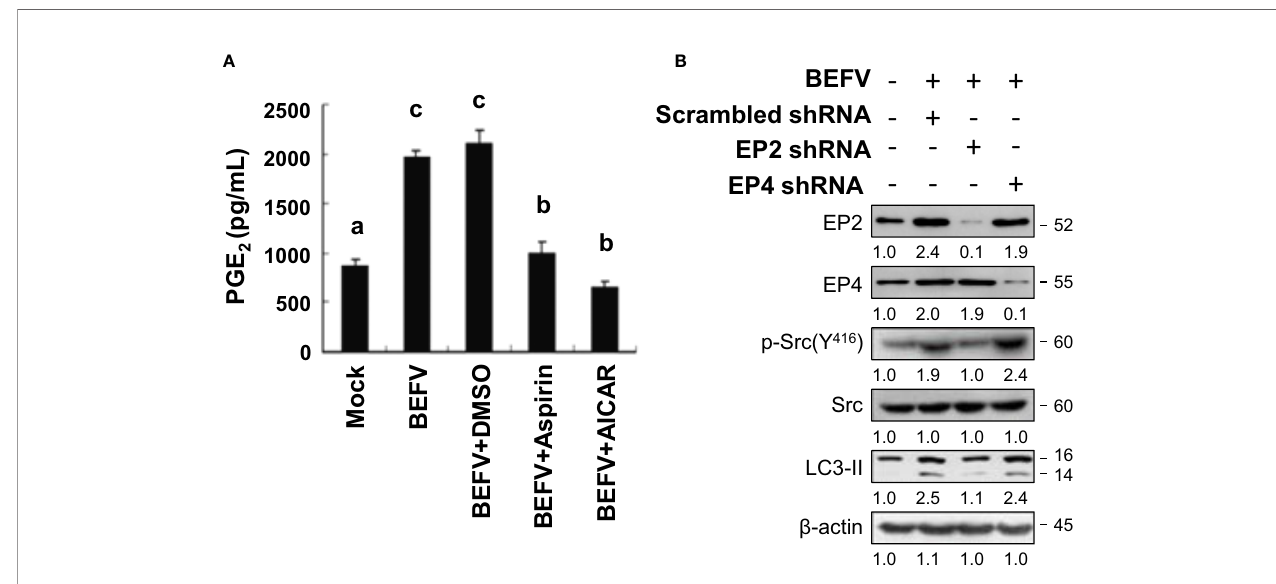
FIGURE 3 | BEFV triggers the PGE2/EP receptor pathway. (A) MDBK cells were pretreated with or without aspirin (5 mM) or AICAR (1 mM), respectively, for 30 min and then infected with BEFV at an MOI of 1 for 18 h. Supernatants of BEFV-infected cells were harvested for quanti fi cation of PGE2 measured by enzyme linked immunosorbent assay (ELISA). Signi fi cance between the treatments was determined by Duncan ’ s Multiple Range Test (MDRT) using SPSS software (Version 20.0). Means with common alphabets (a, b, c) denotes no signi fi cance at p <0.05. Each value represents mean ± SE of three independent experiments. (B) MDBK cells were transfected with scrambled (negative control), EP2, and EP4 shRNAs, respectively, for 24 h, followed by infection with BEFV at an MOI of 1 for 18 h. The effect of E-prostanoids (EPs) on BEFV-induced LC3 II was analyzed by immunoblotting. The levels of indicated proteins in the mock group were considered onefold. The activation and inactivation folds indicated below each lane were normalized against values for the mock control group. b ‐ actin was used for the internal control for normalization. Signals in all Western blots were quanti fi ed with ImageJ software. All experiments were conducted in three independent experiments. The predicted size of each protein was labeled at the right-hand side in